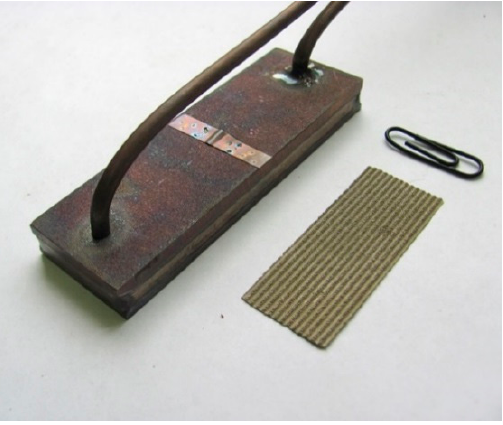
Figure 19. The microchannel reactor and catalyst ‐ loaded microchannel plate.